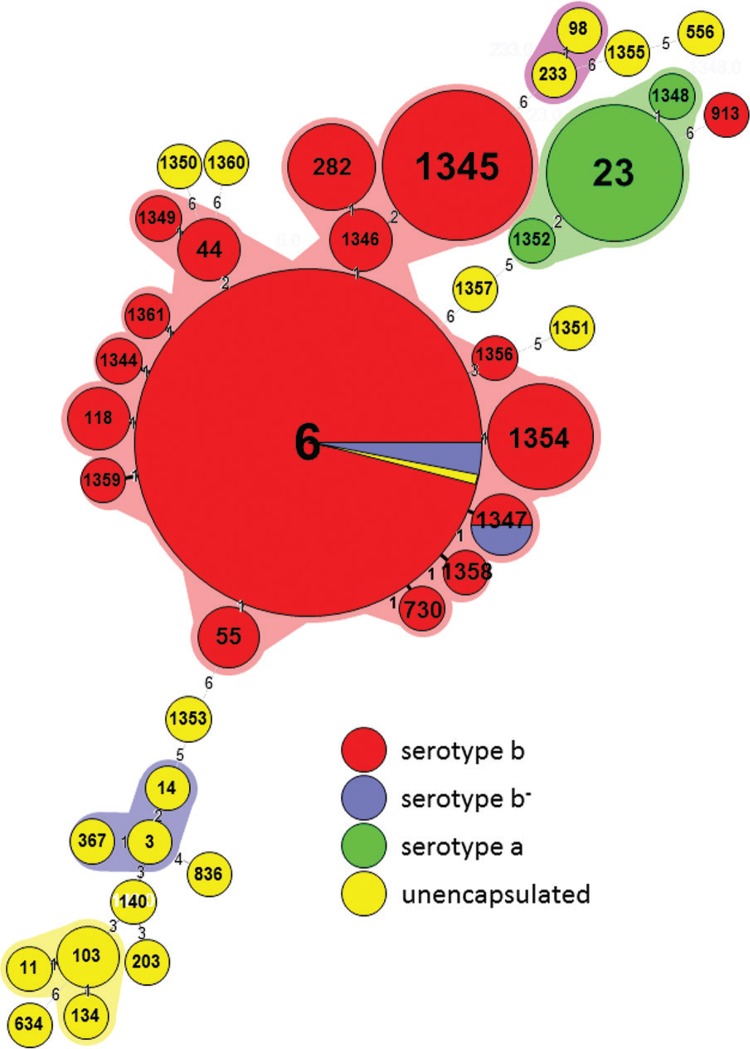
: Haemophilus influenzae clustered by multilocus sequence typing clonal complex, labelled by sequence type, colour coded by serotype.